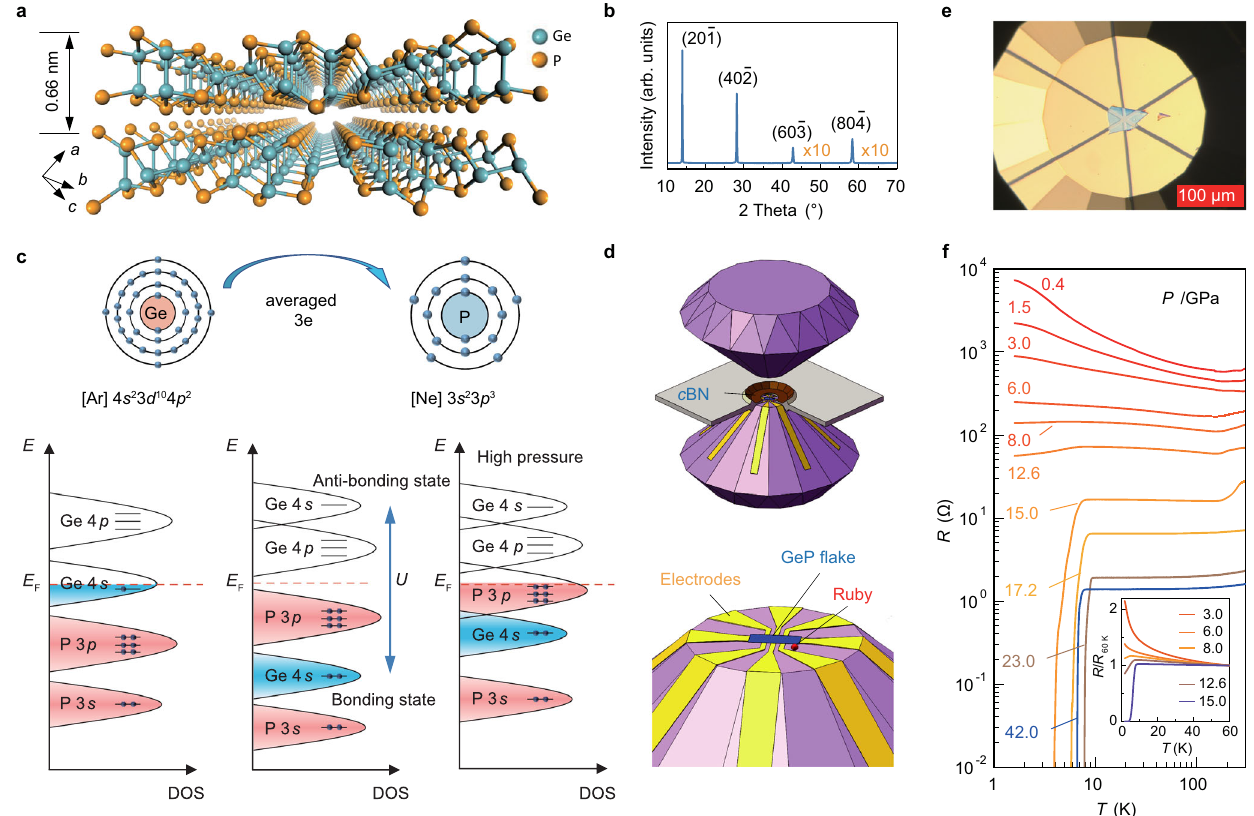
Fig. 1 | Crystal structure, electron fi lling in orbitals, and insulator – superconductor transition of valence-skipping GeP van der Waals crystal under pressure. a Schematic crystal structure of GeP. Cyan and orange balls represent Ge and P atoms. b XRD spectrum of GeP single crystal. c The elec- tron con fi guration of Ge and P atoms. Bottom panels are schematicillustrations of theDOSindifferentscenariosforelectron fi llingstates.GePshouldbeametalwith a half- fi lled Ge-4 s orbital according to the band theory 18 (left panel), however, it is an insulator realized by the negative- U interaction between electrons splitting the